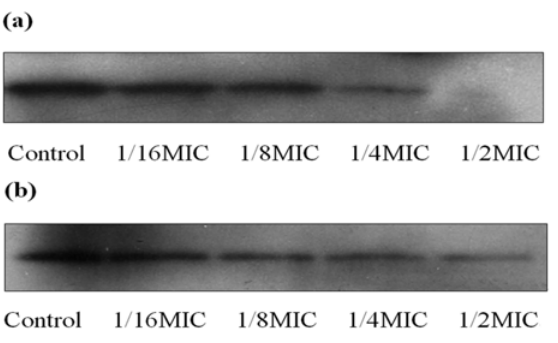
Figure 4. Western blot analysis of α -toxin secretion by strain ATCC 29213 (a) and MRSA strain 3701 (b) after growth with increasing concentrations of magnolol.